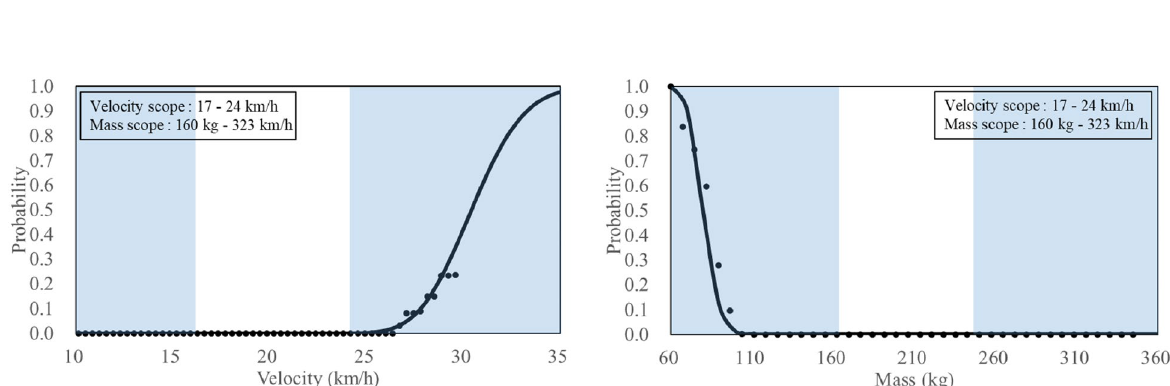
Figure 17. Fragility curves under same local impact energy 3.6